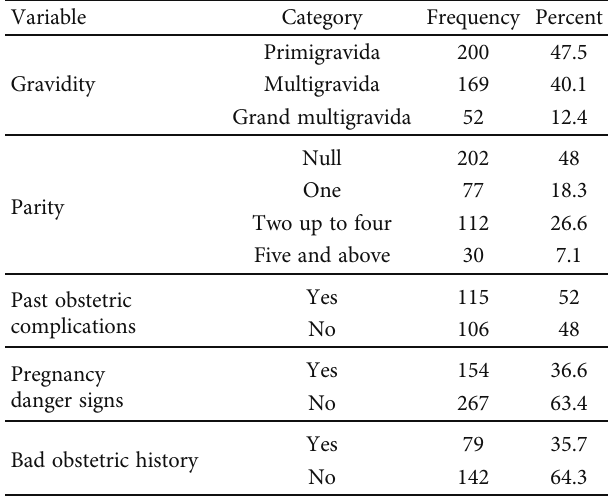
Table 2: Obstetric characteristics of pregnant women attending antenatal care at Jabi Tenhan District health centers in April 2021 ( n = 421